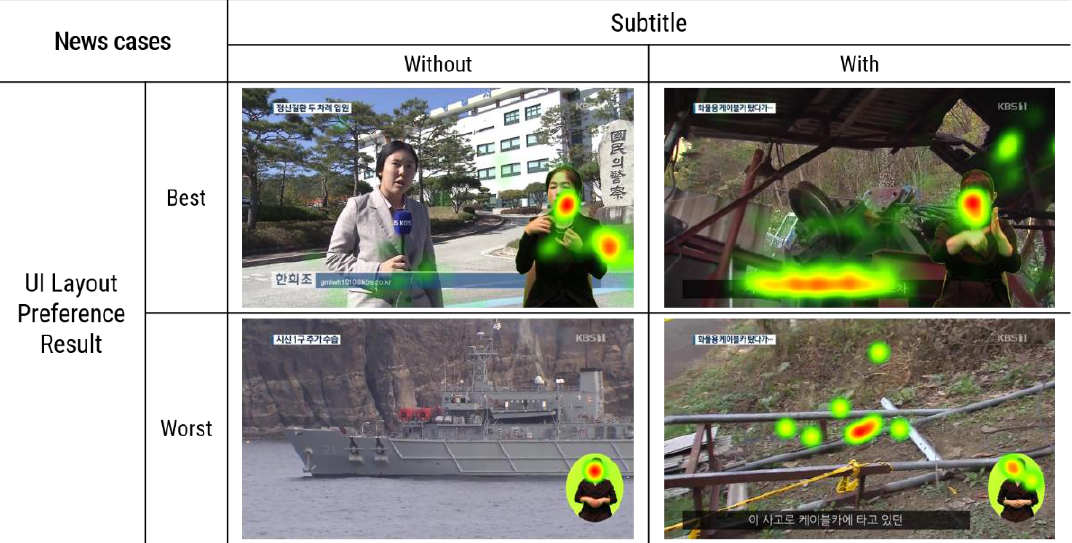
Figure 12. Results of eye tracker experiments with news cases.